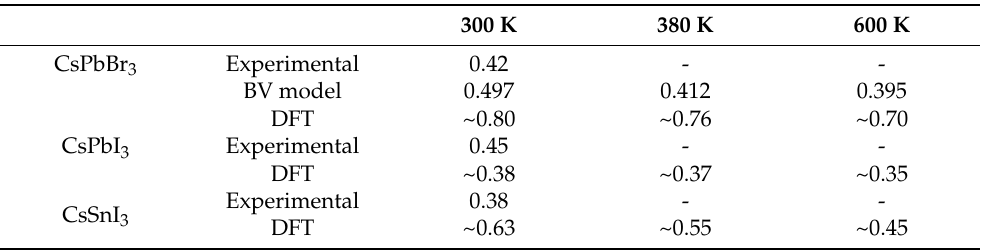
Figure 7. ( a ) Thermal conductivity κ of tetragonal structure at 380 K; ( b ) thermal conductivity κ for cubic structure at 600 K. Table 4. The thermal conductivity calculated by the BV model and comparison with materials with a similar structure to CsPbBr 3